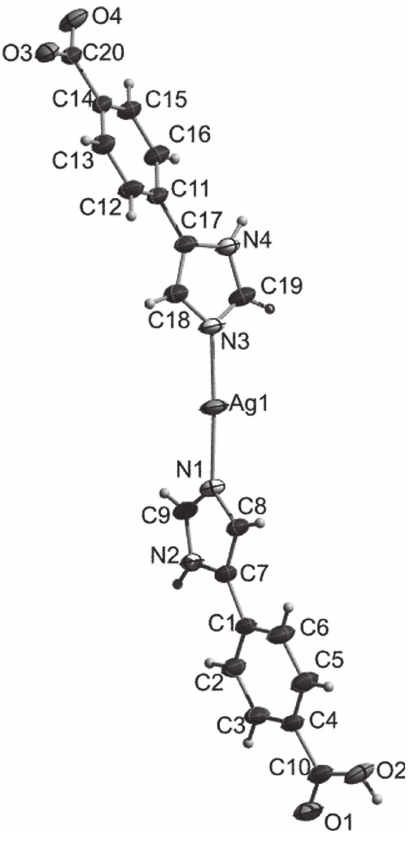
Table 1: Data collection and handling.